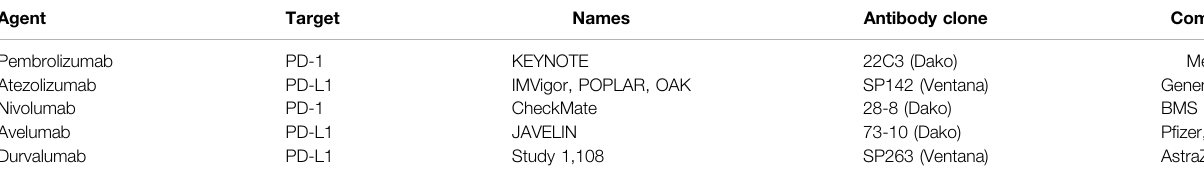
TABLE 4 | List of clinically approved PD-1/PD-L1 inhibitors.